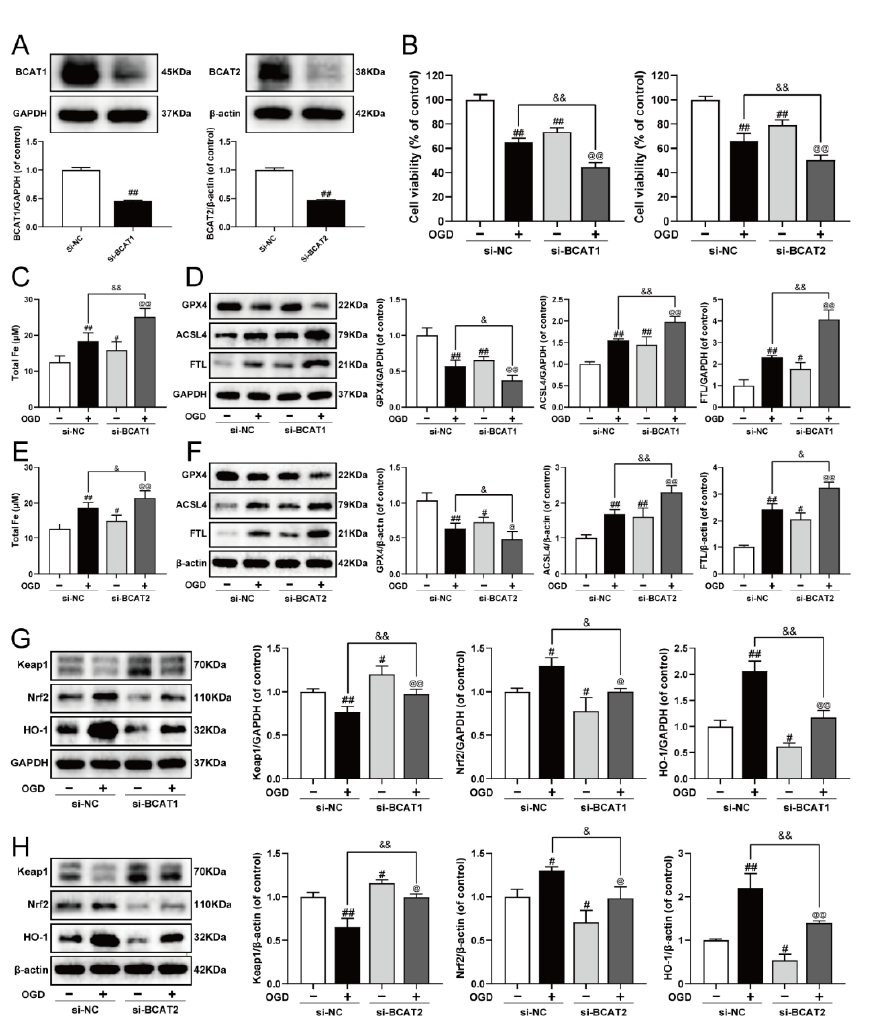
Figure 5. Knockdown of BCAT1 or BCAT2 aggravated ferroptosis and restrained the Keap1/Nrf2/HO-1 signaling pathway in H9c2 cardiomyocytes. ( A ) Western blotting analysis of BCAT1 and BCAT2 in H9c2 cardiomyocytes transfected with BCAT1 siRNA or BCAT2 siRNA ( n = 3–4). ( B ) The cell viability of H9c2 cardiomyocytes transfected with BCAT1 siRNA or BCAT2 siRNA ( n = 6). ( C ) The content of total iron of H9c2 cardiomyocytes transfected with BCAT1 siRNA ( n = 6). ( D ) Western blotting analysis of GPX4, ACSL4, and FTL in H9c2 cardiomyocytes transfected with BCAT1 siRNA ( n = 3). ( E ) The content of total iron of H9c2 cardiomyocytes transfected with BCAT2 siRNA ( n = 6). ( F ) Western blotting analysis of GPX4, ACSL4, and FTL in H9c2 cardiomyocytes transfected with BCAT2 siRNA ( n = 3). Western blotting analysis of Keap1, Nrf2 and HO-1 in H9c2 cardiomyocytes transfected with ( G ) BCAT1 siRNA or ( H ) BCAT2 siRNA ( n = 3). Results